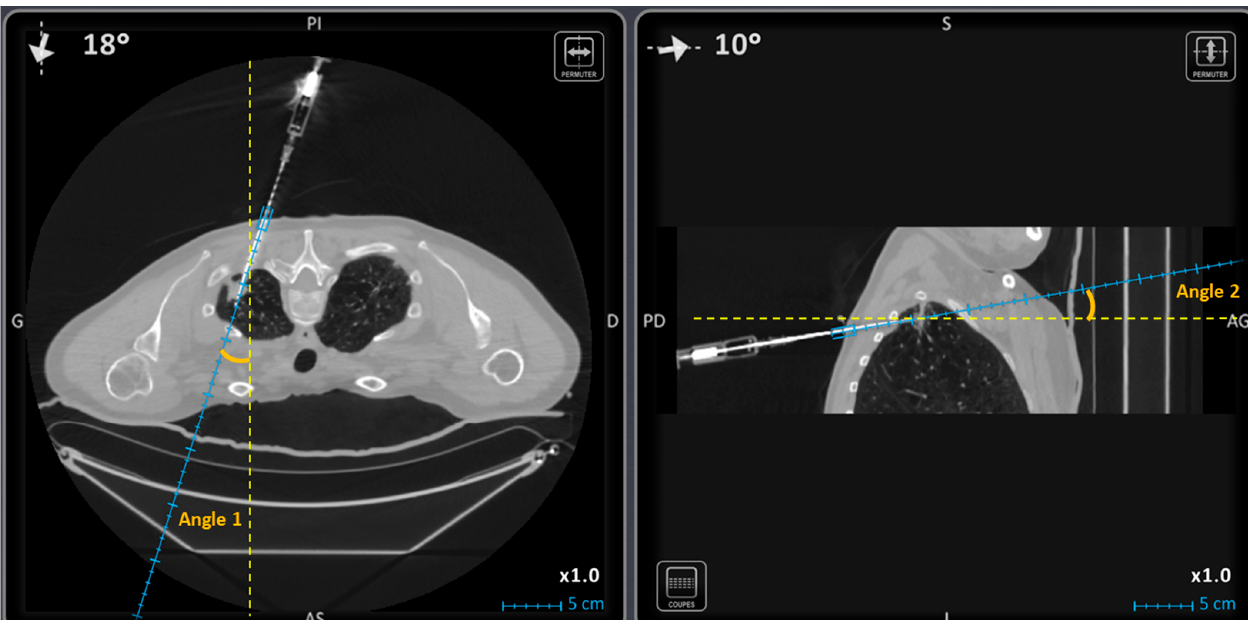
Figure 2. The two trajectory angles on the 2D reconstructed perpendicular images in the axial plane on the left (angle 1) and the sagittal oblique plane on the right (angle 2).